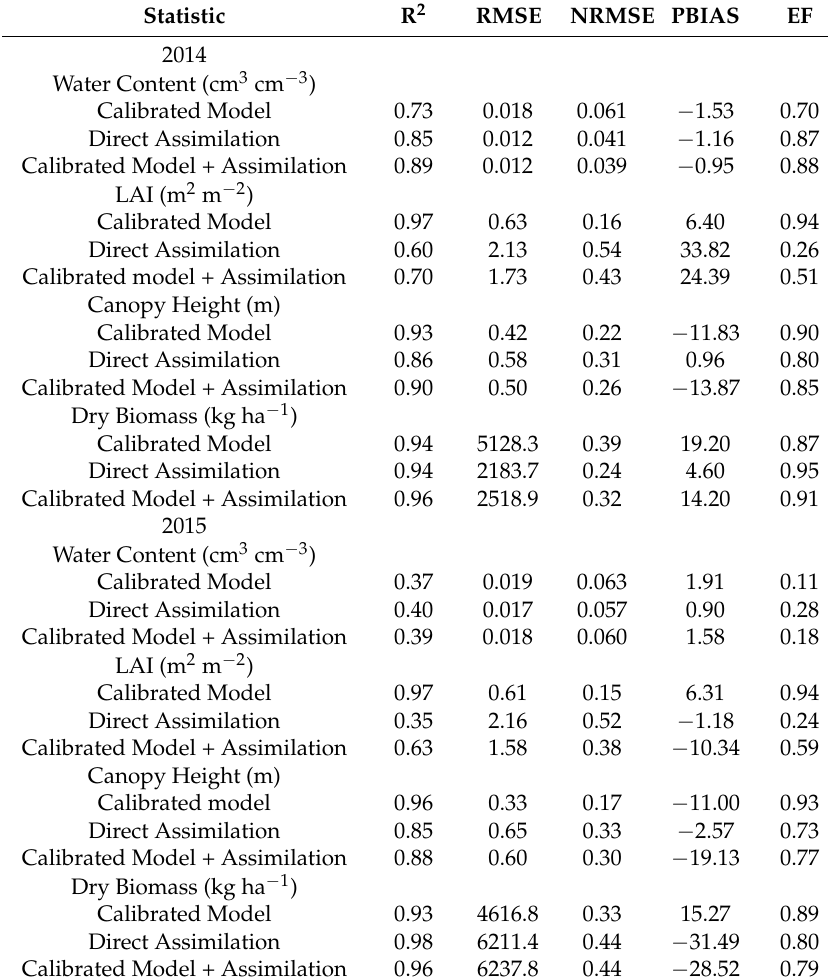
Table 6. Results of the statistical analysis between measured and simulated soil water contents, leaf area index (LAI), canopy height and aboveground dry